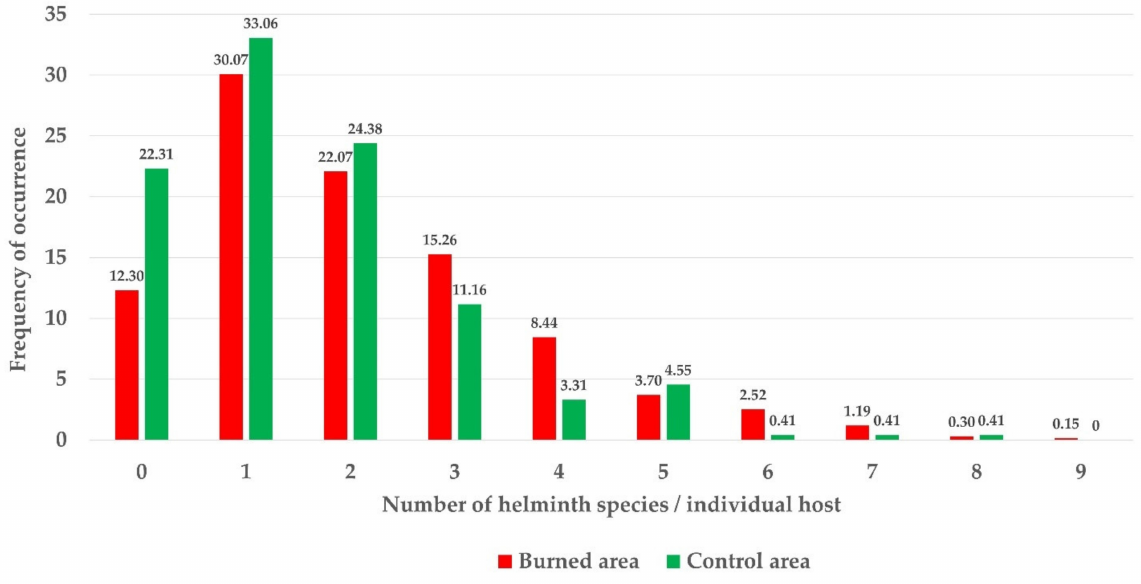
Figure 7. Frequency of occurrence of the number of helminth species present in the infracommunities of the wood mouse in the burned and control